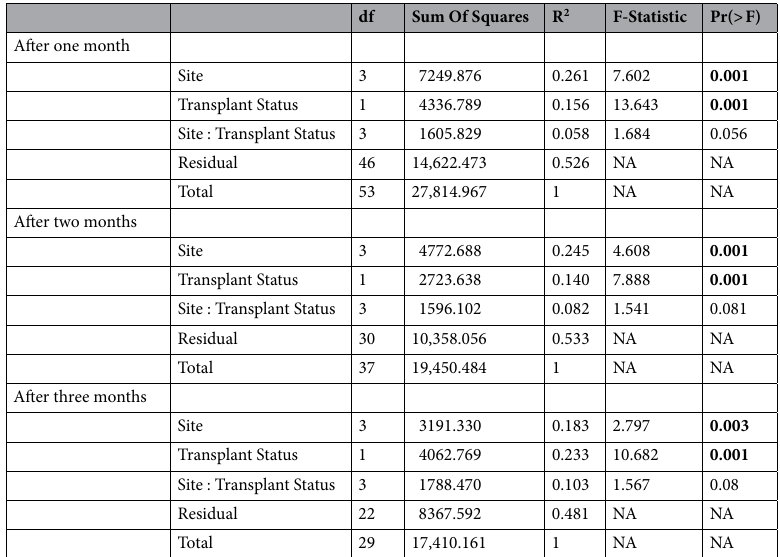
Table 4. Results of PERMANOVA showing differences among based on variation in transplant status in roots (see Fig. 3D-F). Significant values are in